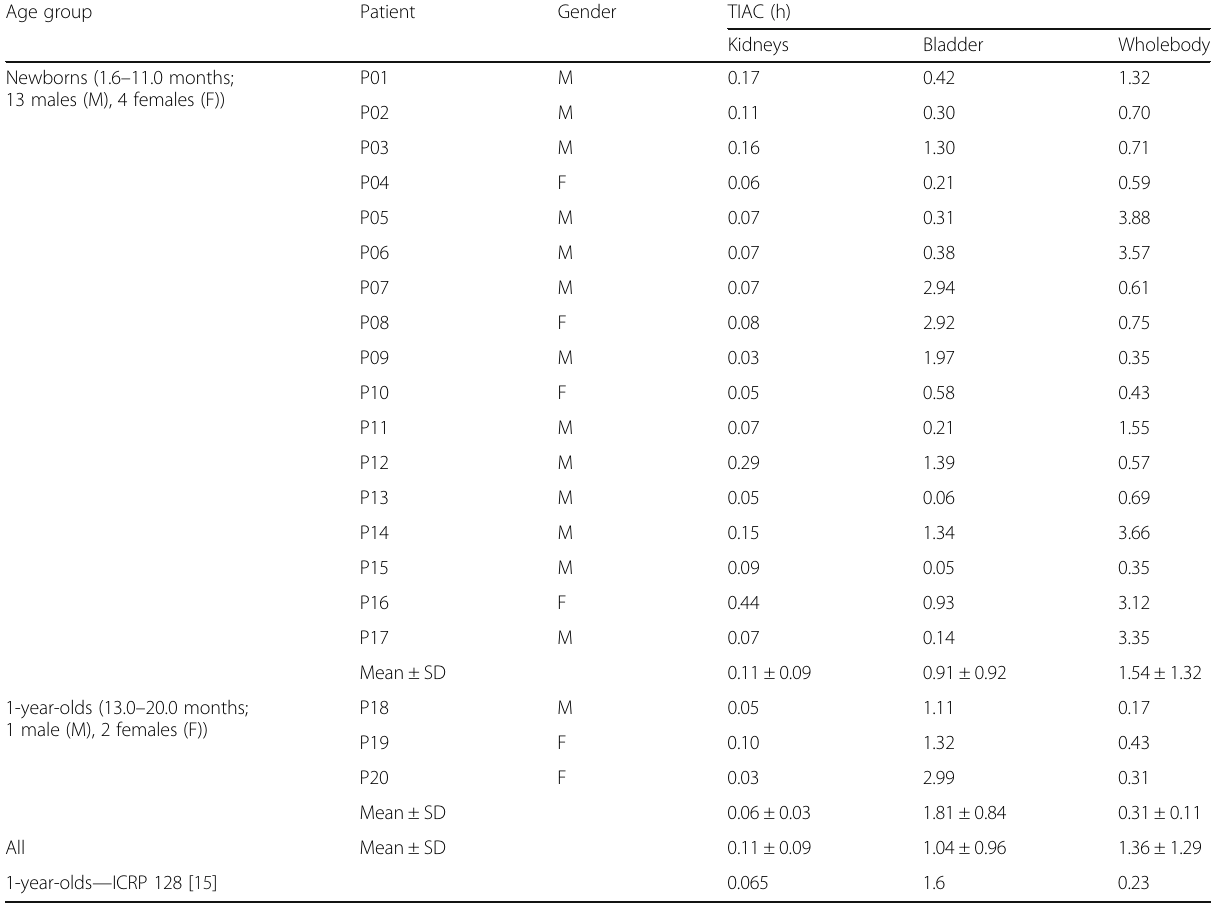
Table 1 Organ-specific time-integrated activity coefficients (TIACs) in hours for all patients (classified into age